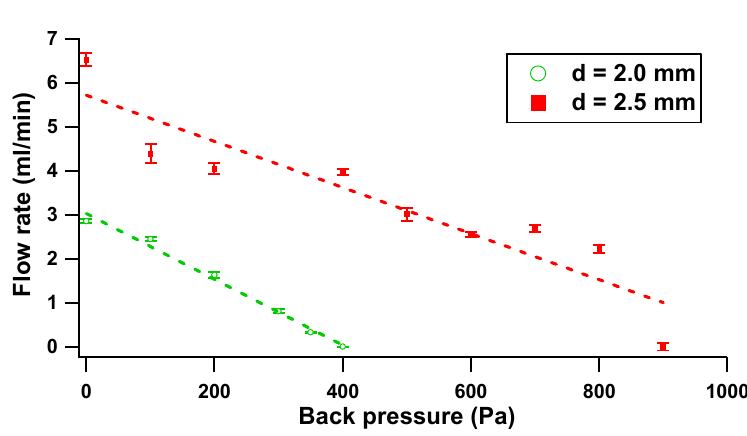
Figure 11. Flow rate vs. Back pressure.